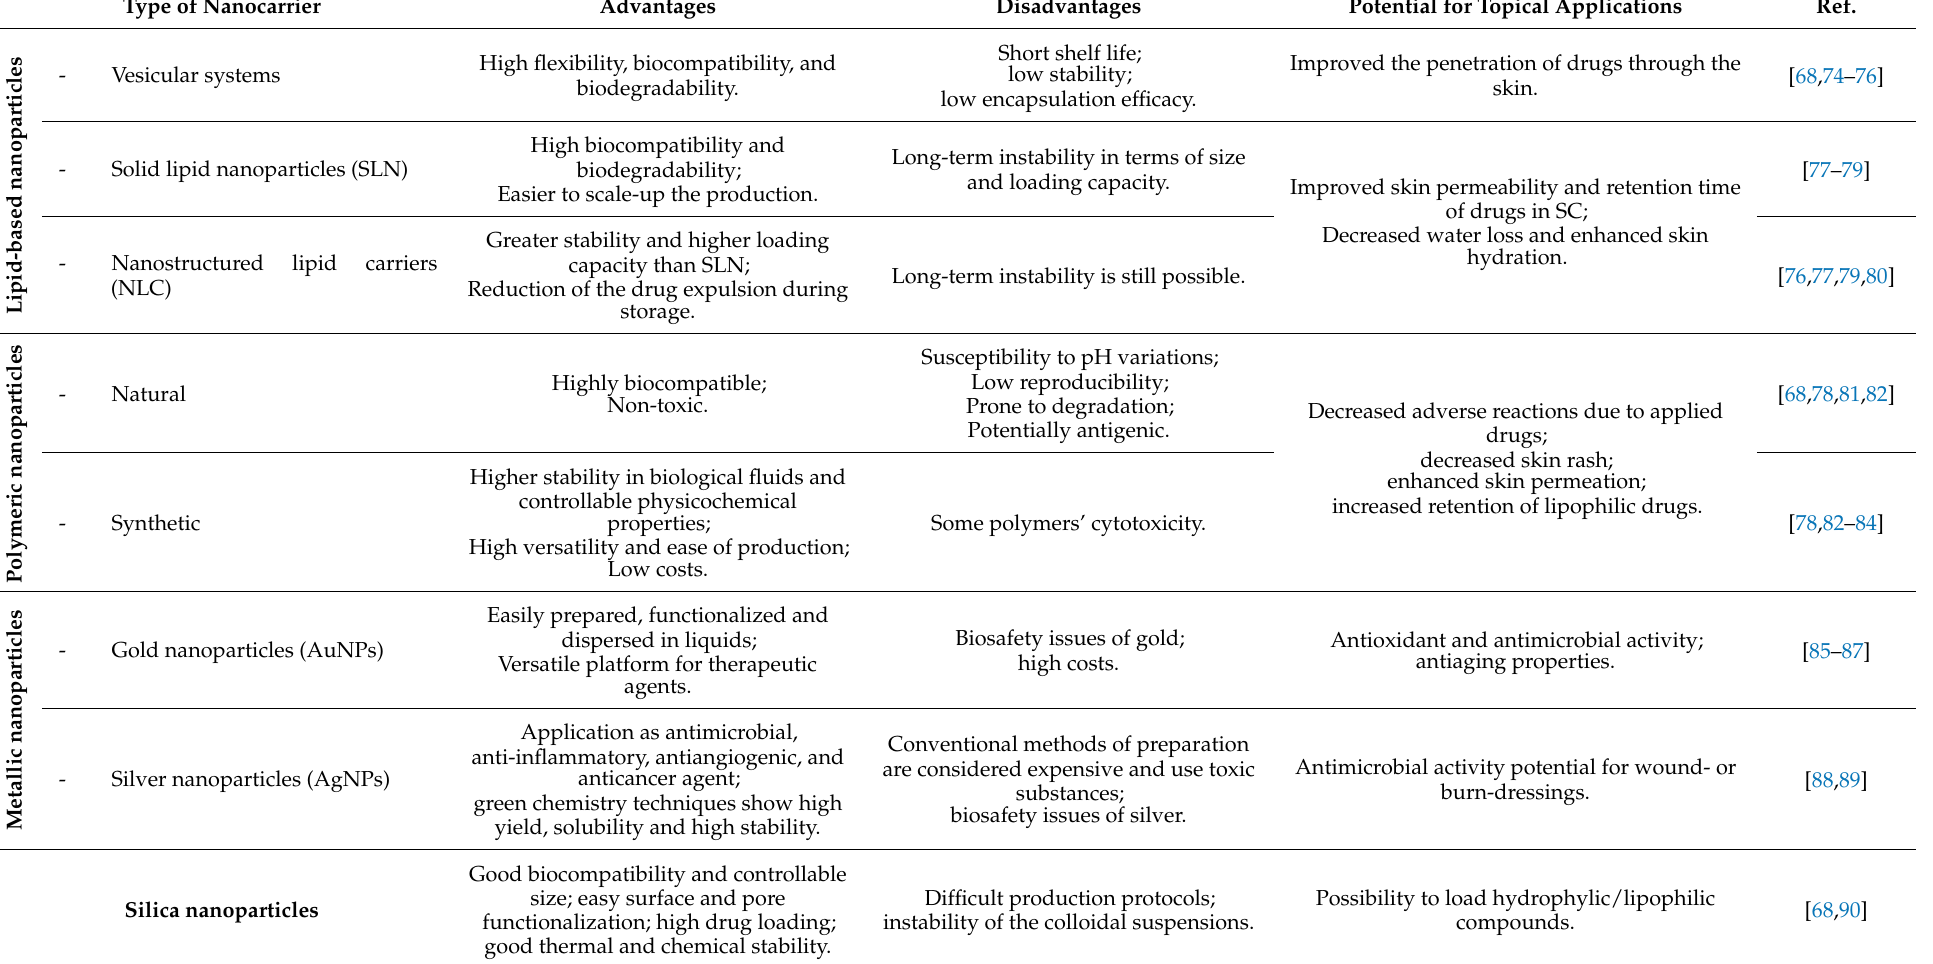
Table 1. Advantages and disadvantages of each type of nanocarriers and its main potential for topical skin